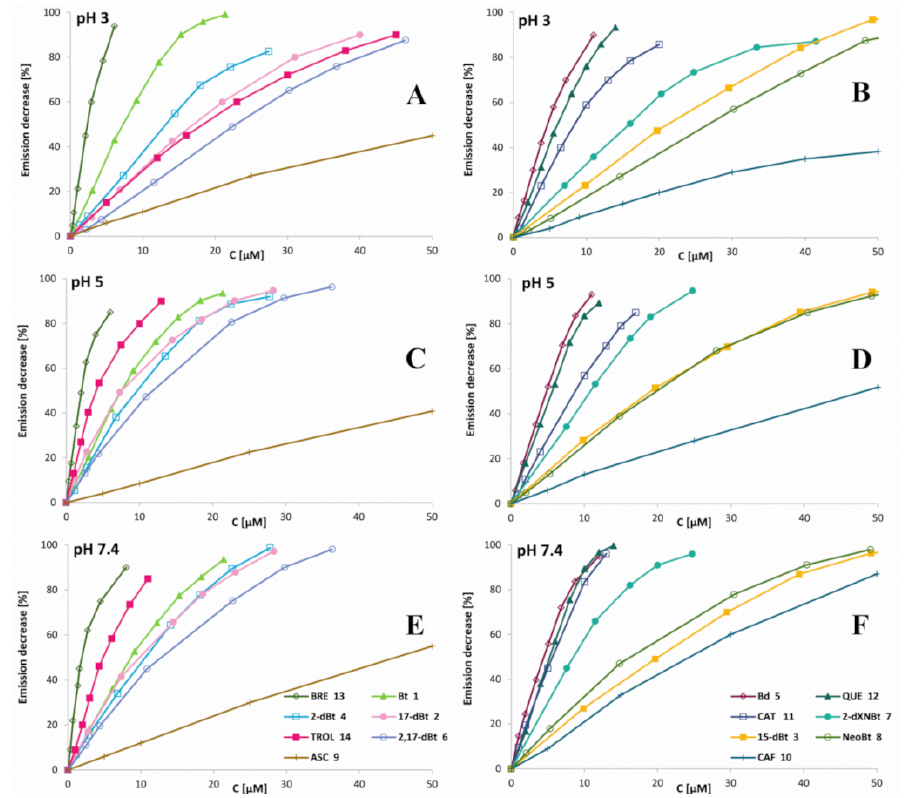
Figure 7. Percentile decrease in fluorescence intensity of the 150 µ M HCSe probe ( λ Ex 480 nm, ◦ C) added to 150 µ M NaOCl solution after its 5 min incubation with BRE as well λ Em 536 at 25 as analyzed pigments (betanin ( Bt ), 17-decarboxy-betanin ( 17-dBt) , 15-decarboxy-betanin ( 15-dBt ), 2-decarboxy-betanin ( 2-dBt ), betanidin ( Bd ), 2,17-decarboxy-betanin ( 2,17-dBt ), neobetanin ( NeoBt ), and 2-decarboxy-xanneobetanin ( 2-dXNBt )), and selected antioxidants (ascorbic acid ( ASC ), caffeic acid ( CAF ), catechin ( CAT ) and quercetin ( QUE )) as well as for the betalain-rich extract ( BRE ) and Trolox ( TROL ) of increasing concentration at pH 3 ( A , B ), 5 ( C , D ) and 7.4 ( E , F ). For clarity, only selected single measurement series were